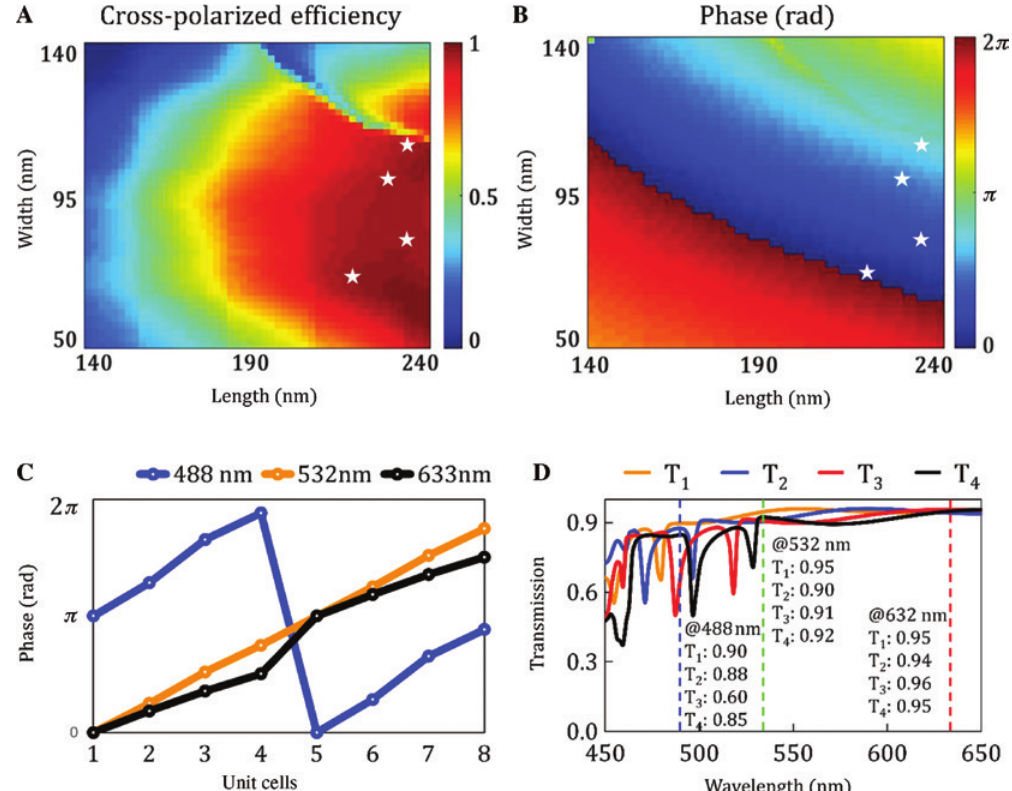
Figure 2: Numerical optimisation of the GaN nanorods. Simulated cross-polarised transmission (A) efficiency and (B) phase of the nanorods with varying dimensions at a fixed wavelength of 532nm. The displacement ( U ) of the unit cell is equal to 260 nm and the height ( h ) is fixed at 600 nm. White stars indicate the selection of four nanorods based on their high cross-polarised efficiencies and desired phase shifts. (C) Eight unit cells with eight different nanorods that provide full phase coverage (0–2 π ) at three common wavelengths (488, 532 and 632 nm). The dimension (length × width) of nanorods of unit cells 1–4 are N1: 220 × 70, N2: 235 × 80, N3: 230 × 100 and N4: 235 × 110 in the nanometer scale, respectively. Unit cells 5–8 have the same dimension as unit cells 1–4 with the long axis of the nanorods orthogonally oriented with respect to the x-axis. (D) Simulated total transmission (T , T , T and T ) of unit cells (1–4, respectively) as a function of wavelength from 450 nm to 650 nm. The vertical dashed 1 2 3 4 lines are drawn at 488, 532 and 632 nm. The inset, for example, @532, outlines the values of transmission efficiencies at a wavelength of 532 nm. The simulations are performed here are under normal incident angle. The effect of different incident angles on the transmission curves of unit cells 1–4 are mentioned in Section S4 of Supplementary